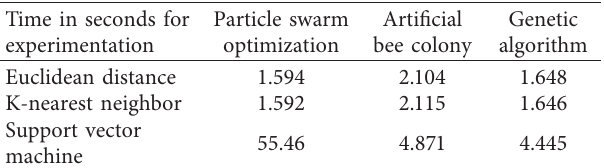
Table 12: Average time taken for experiments.